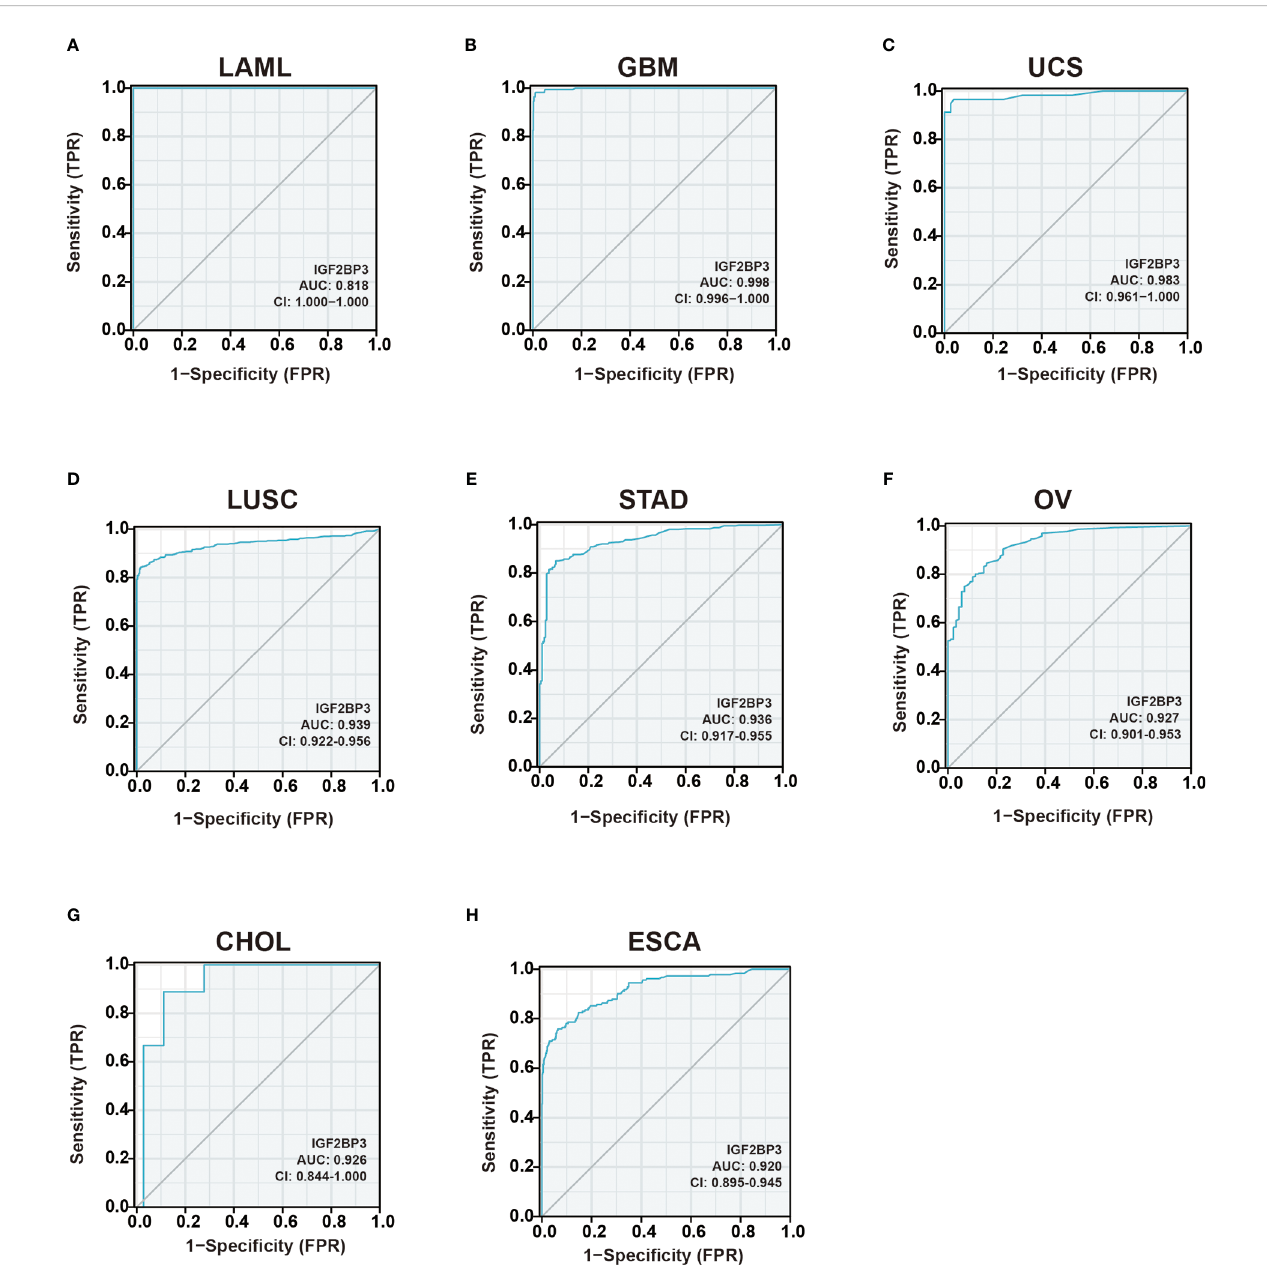
FIGURE 4 Receiver operating characteristic (ROC) curve for IGF2BP3 expression in pan-cancer. (A) LAML; (B) GBM; (C) UCS; (D) LUSC; (E) STAD; (F) OV; (G) CHOL; (H)